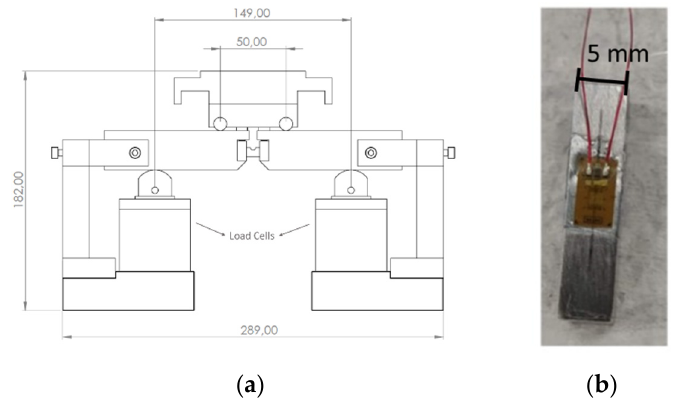
Figure 7. Calibration setup: ( a ) Four-point bending system, dimensions in mm [17]; ( b ) Strain gauge on specimen (reference MMF307385).